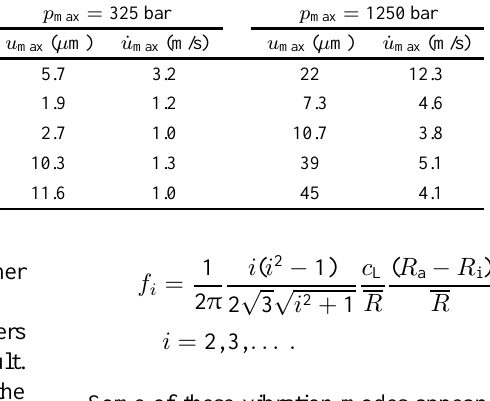
Frequencies, maximum displacements u max (peak to peak) and vibration velocities _ u max (amplitude) for certain common tube geometries and different detonation pressures p max . Calculation is based on a modulus of elasticity E = 2 : 0 (cid:2) 10 11 N/m 2 and a density (cid:26) = 7900 kg/m 3 . The wall material was assumed